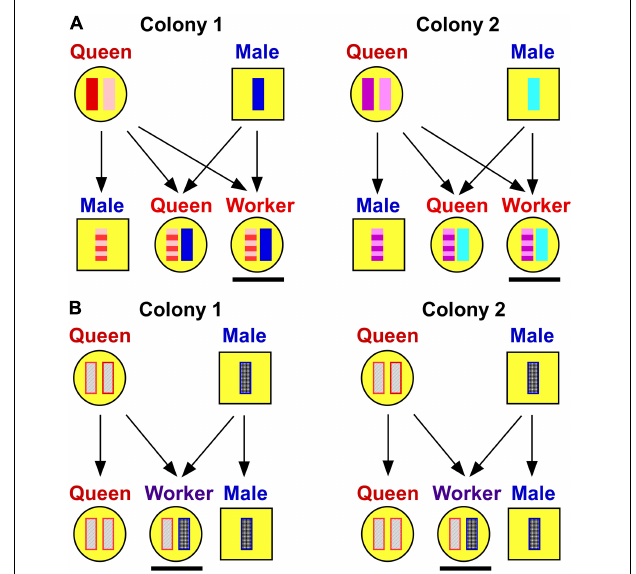
FIGURE 3 | The effects of “standard” and “non-standard” genetic systems on relatedness in ants. (A) Genetics of a standard, monogynous, monandrous ant. Haplodiploid genetics lead to relatively high relatedness of 0.75 between female offspring within colonies whereas non-colonymates, such as the underlined workers, are effectively unrelated. Therefore, individuals are expected to engage in cooperative behaviors colonymates who are kin. (B) Unorthodox genetic system found in some ants leads to unusual relationships. In the case of the long-horned crazy ant, Paratrechina longicornis , for example, underlined workers are produced by “hybridization” of genetically differentiated queens and males, whereas queens and males are effectively cloned. The consequence of this system is that workers in one colony are ultimately genetically identical to workers in other colonies. Moreover, workers are unrelated to their male and queen “siblings” within colonies. The consequences of this type of genetic system on the evolution of cooperative behaviors are